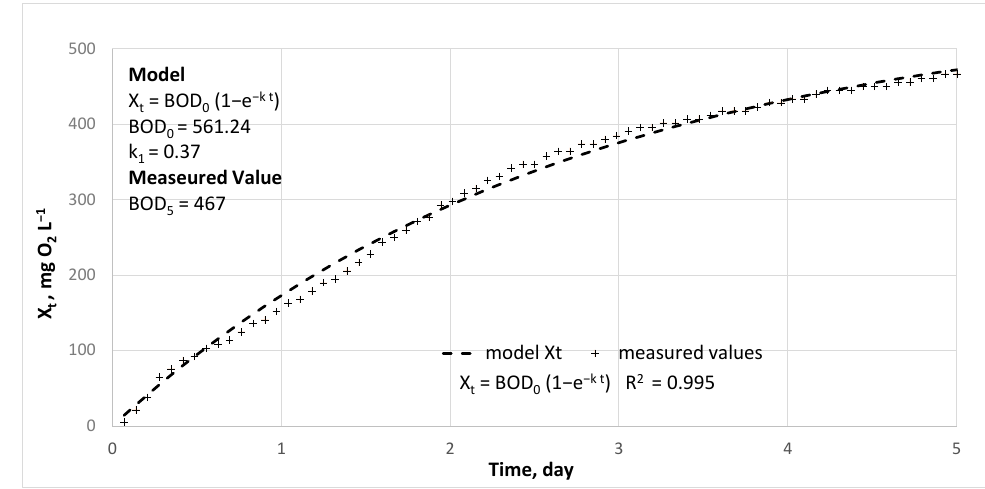
Figure 4. Value of biochemical oxygen consumption in rejected water, WWTP 1, sample 1.